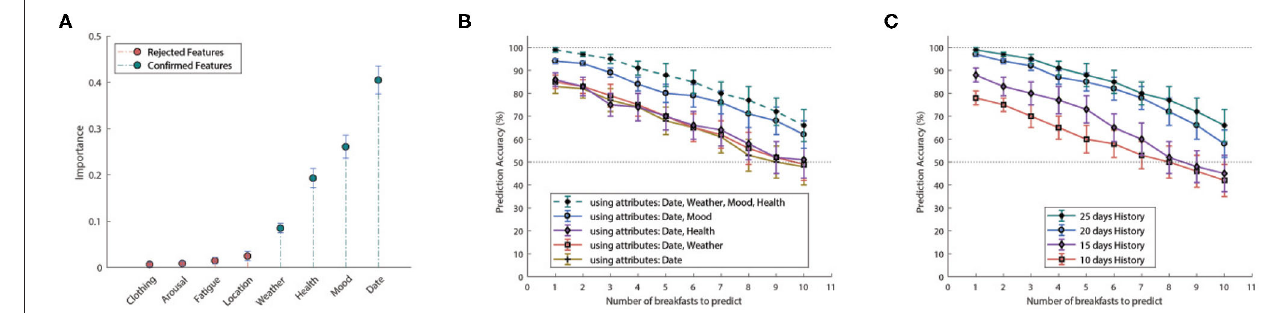
FIGURE 7 | (A) Feature importance according to Boruta feature selection algorithm. Features with red color are characterized as non-important and are rejected, whereas features with green color are characterized as important and are accepted. Inference accuracy w.r.t. prediction days and (B) number of attributes, (C) training